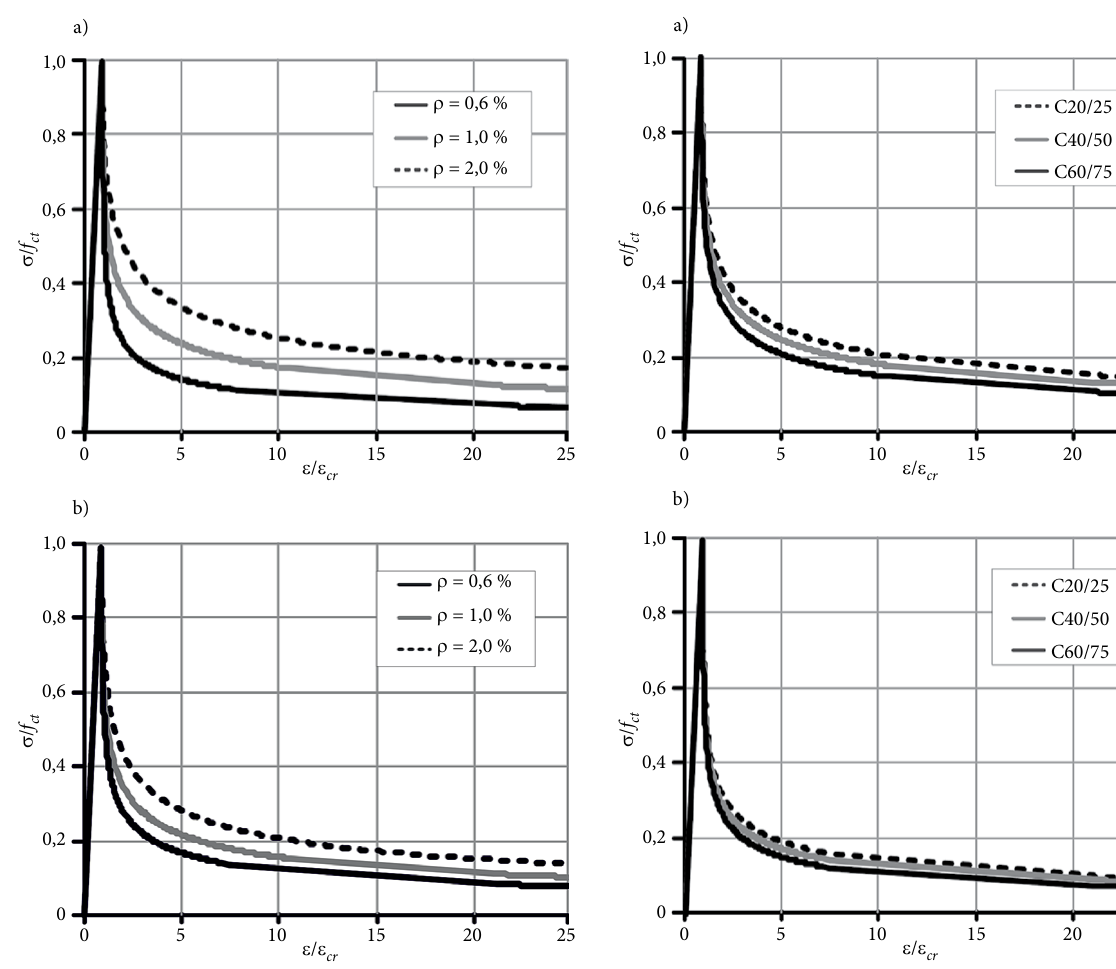
diagramos, kintant armavimo koeficientui: a - C20/25; b - C60/75 Fig. 5. Numerically derived tension stiffening diagrams of varying reinforcement ratio: a - C 20/25; b - C 60/75